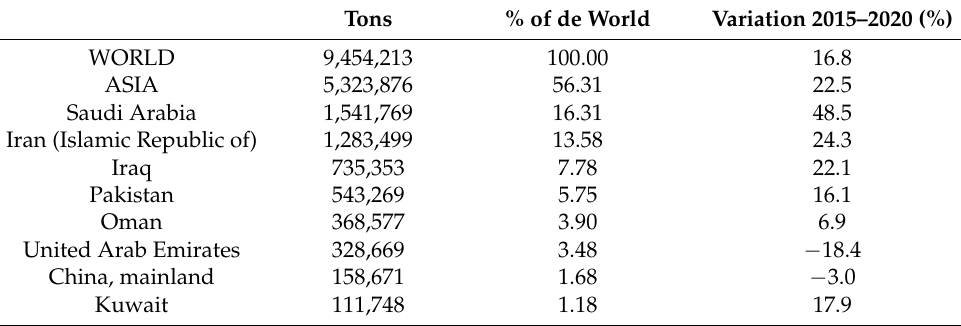
Table 1. Date production in 2020 (tons) of the main producing countries *.